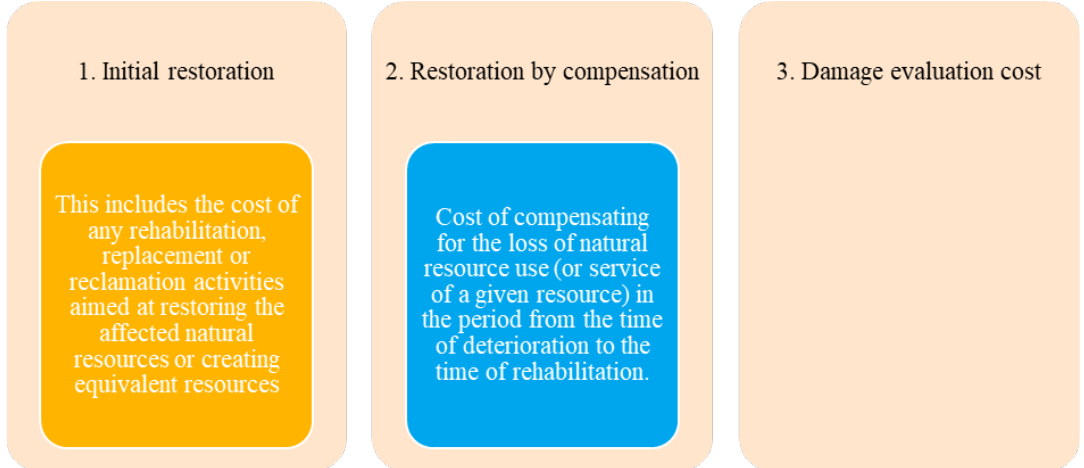
Fig. 2. Types of environmental destruction compensation